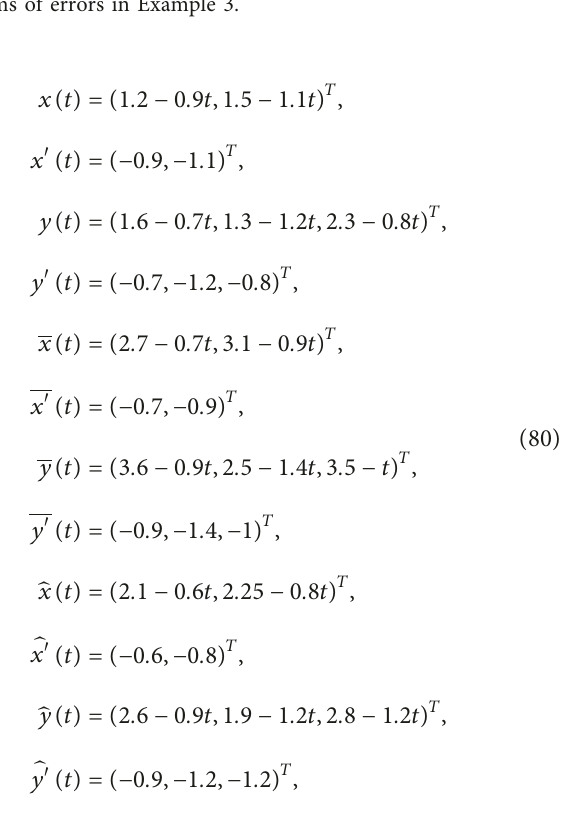
Figure 7: Time evolutions for the norms of errors in Example